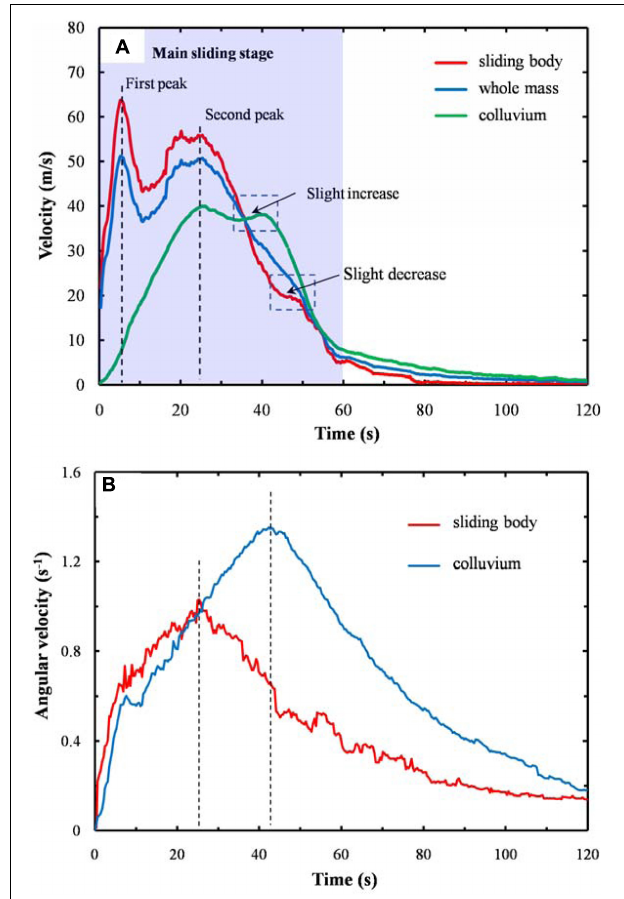
FIGURE 12 | Numerical results of the velocity evolution among the mass movement process: (A) evolutions of average velocity of sliding body, colluvium, and whole mass and (B) evolutions of average angular velocity of sliding body and colluvium. The velocity curves for the sliding body, the colluvium, and the whole body all have two distinct maxima. The angular velocity curves of both the sliding body and the colluvium have only one maximum value and the time at which the angular velocity reaches its maximum is the same as their respective times of reaching the second velocity